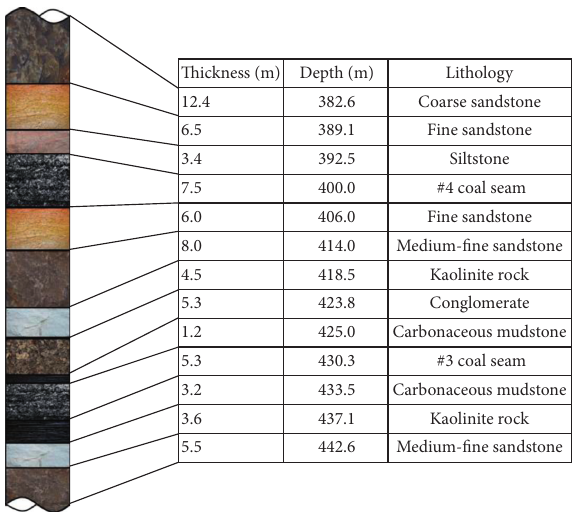
Figure 1: Stratigraphic column at the study